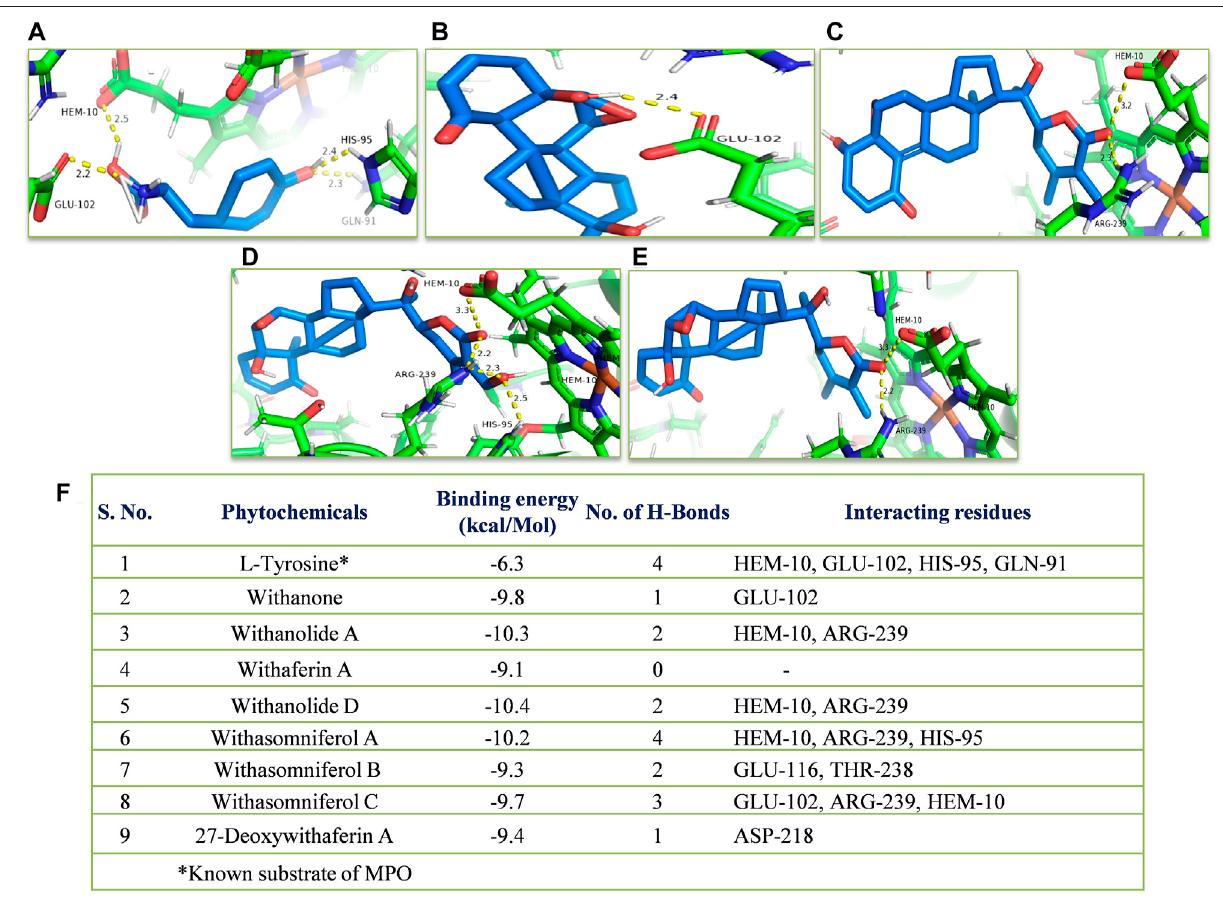
FIGURE 9 | Molecular docking of the proposed withanolides with MPO. Docked conformations of withanolides and substrate (A) tyrosine, (B) withanone, (C) withanolideD; (D) withasomniferolA, (E) withanolide (A) withintheMPOsubstrate-bindingcavity; (F) moleculardockingresultstable.Theproteininteractingresiduesare labeled (in black) with the H-bond interactions (represented by yellow dashed